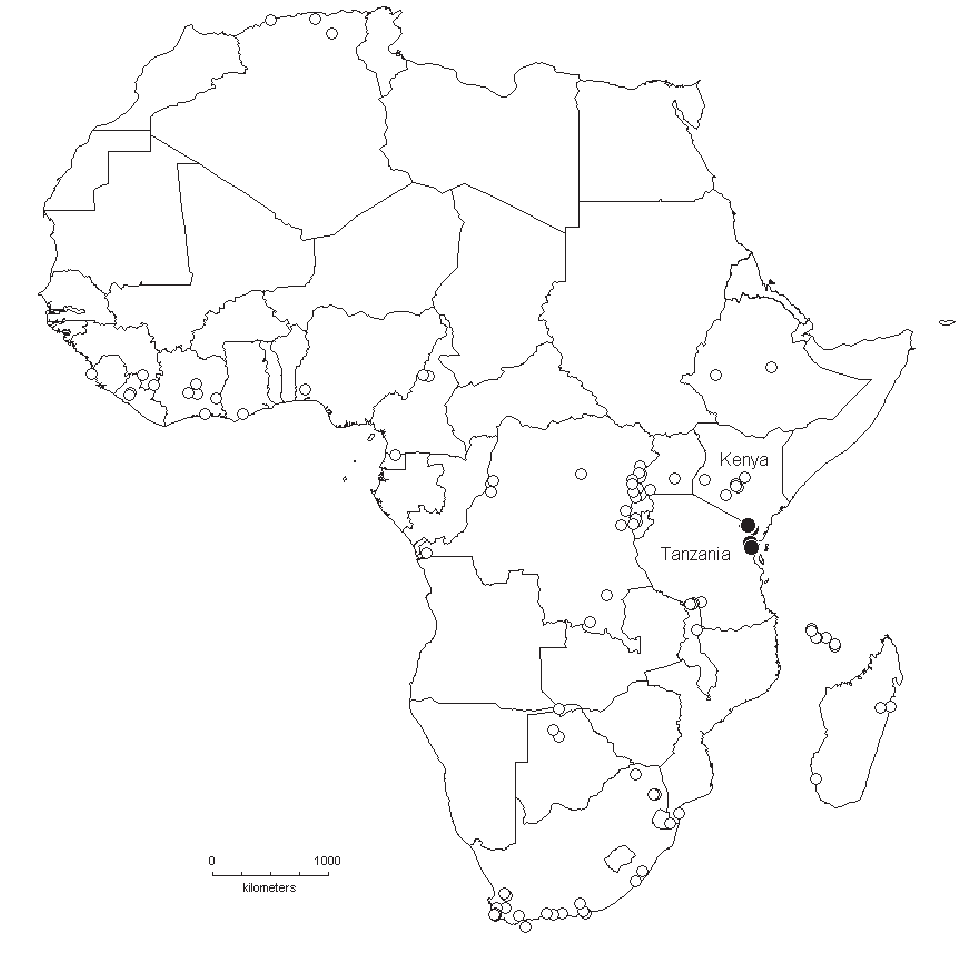
Fig. 13. Map showing all localities of georeferenced Liocranidae in the collections of MRAC: Cteniogaster gen. nov. (●), all other Liocranidae (○) (n =